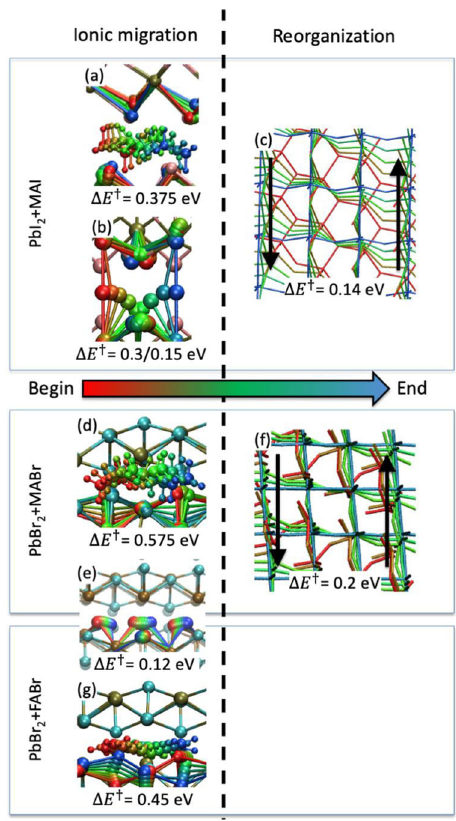
Fig. 5 Paths of the various stages of the conversion reaction. We use a stroboscopic representation of motion to draw the dynamics of the relevant atoms involved in the various processes: the atoms and the bonds are coloured in red at the beginning of the process and, passing by the green, become blue at the end. The barrier associated with each stage is also reported in Fig. 4. Panels a , b , d , e , and e – g show the migration of A + and X - for the MAPbI 3 , MAPbBr 3 and FAPbBr 3 system, respectively. Panels c , f represent the reorganization stage of the process in which MAI-PbI 2 and MA-PbBr 2 transform into MAPI 3 and MAPBr 3 ,